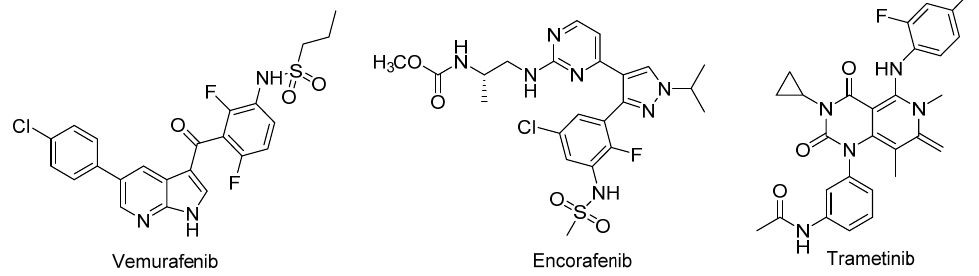
Figure 1. Structures of FDA-approved drugs for metastatic melanoma.